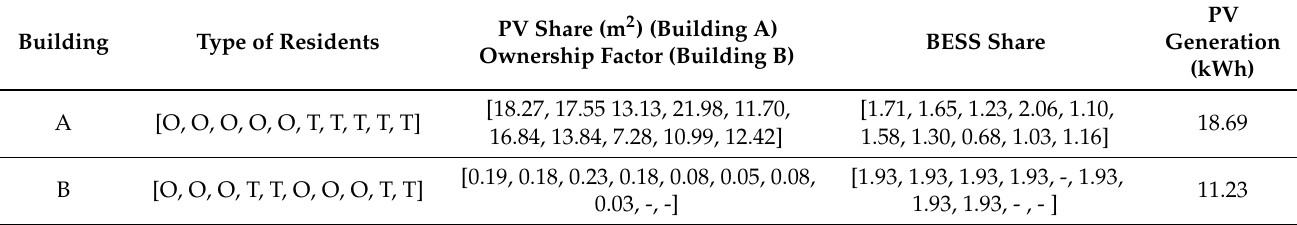
Table 1. System data for allocating energy generated by PV panels to residents of Buildings A and B at time slot 10 (O: unit-owner, T: tenant).